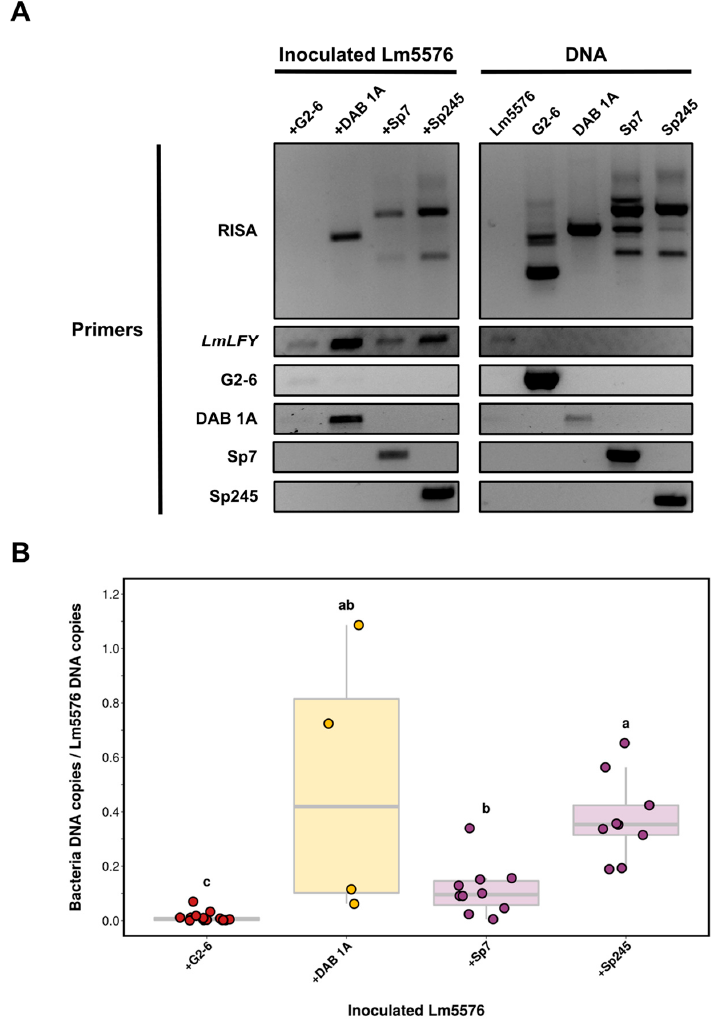
Figure 1. Molecular detection of duckweed-associated bacteria. Axenic Lm5576 was inoculated with different bacteria in 0.5X SH media. After seven days, inoculated Lm5576 tissue was collected, washed with sterile water, and nucleic acids were isolated for analysis. ( A ) Representative gel electrophoresis results of end-point PCR using RISA, LmLFY , and strain-specific primers (File S2). RISA PCR fingerprints from inoculated Lm5576 samples were compared to the respective DNA controls from Lm5576 and bacteria alone. Samples: +G2-6 = Lm5576 inoculated with Bacillus simplex RUG2-6, +DAB 1A = Lm5576 inoculated with Microbacterium sp. RU370.1, +Sp7 = Lm5576 inoculated with Azospirillum brasilense Sp7, +Sp245 = Lm5576 inoculated with Azospirillum baldaniorum Sp245. Primers: RISA = PCR using 16S-1390f and 23S-e130r primers, LmLFY = PCR using LmLFY-F and LmLFY-R primers specific to Lm5576, DAB 1A = PCR using AmRU370.1-F and AmRU370.1-R primers specific to Microbacterium sp. RU370.1, G2-6 = PCR using BsRUG2.6-F and BsRUG2.6-R primers specific to Bacillus simplex RUG2-6, Sp7 = PCR using AbSp7-F and AbSp7-R primers specific to Azospirillum brasilense Sp7, Sp245 = PCR using AbSp245-F and AbSp245-R primers specific to Azospirillum baldaniorum Sp245. ( B ) Bacterial association with Lm5576 was quantified using real-time PCR. Bacterial DNA copy number was determined for each inoculated Lm5576 sample and normalized to Lm5576 DNA copy number. Different colors were used for the different bacterial genera. Each data point represents an experimental repeat except for +G2-6, for which each sample was measured twice. A significant difference was found in colonization levels between bacteria (Kruskal–Wallis, p -value = 4.58 × 10 − 6 ). Pairwise comparisons were performed using Dunn’s test, and results are displayed as compact letters (a–c). Bacteria with significantly different colonization levels from each other, according to Dunn’s test (FDR < 0.05), do not share any letters.